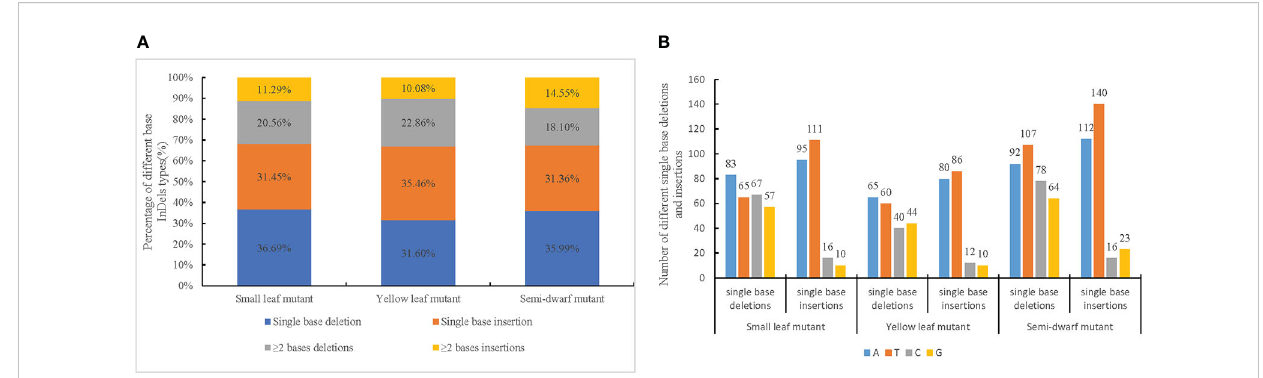
FIGURE 3 Ratio and type of InDels among three mutation lines. (A) Percentage of different base InDels types in each mutation line. (B) Number of different single base deletions and insertions in three